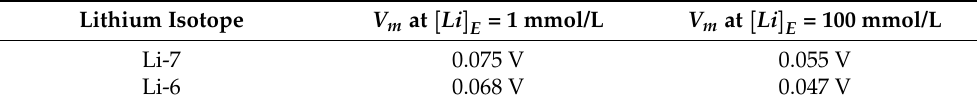
Table 26. The table shows the membrane potential values at extracellular lithium concentration of 1 mmol/L and 100 mmol/L and based on the quantum transport and the corresponding setting values as in graph (a) of Figure 10.